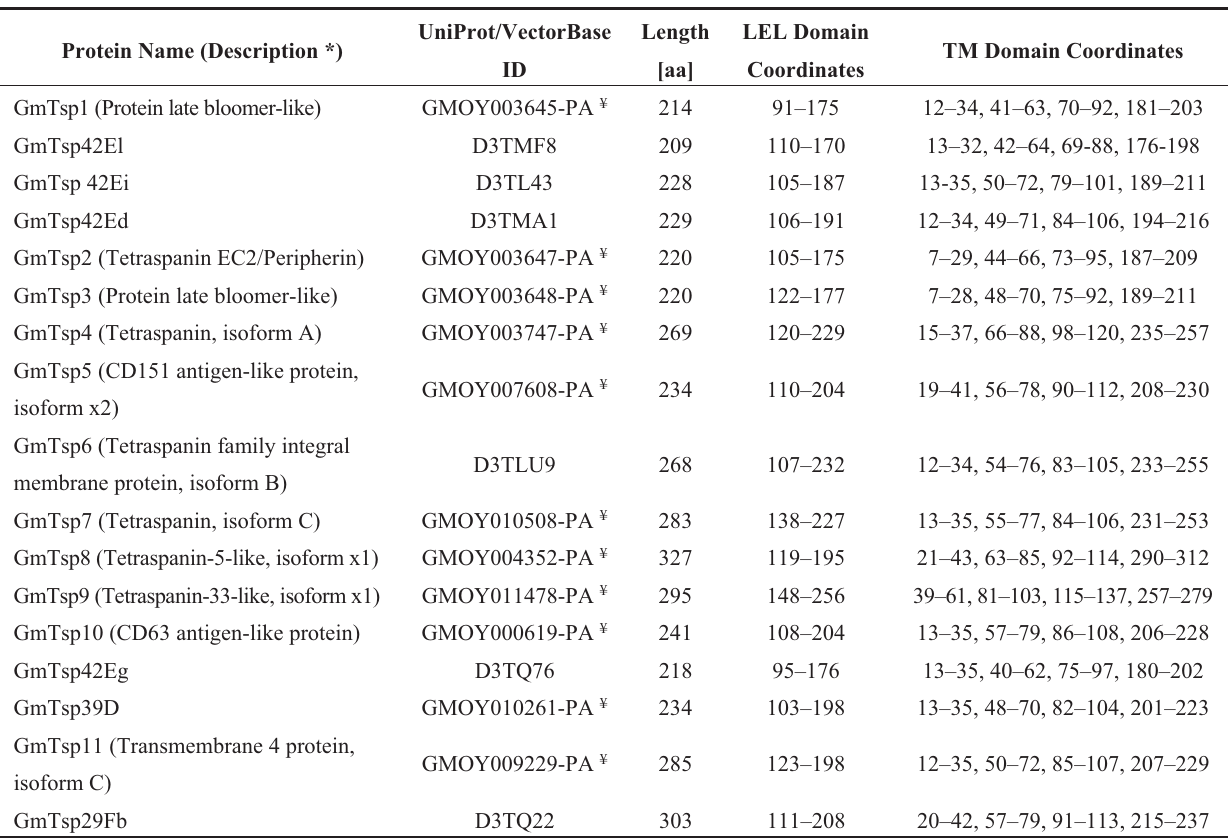
Table 1. Domain characteristics of seventeen GmTsp proteins in the genome of G. morsitans . The coordinates of the large extracellular loop (LEL) and the four transmembrane domains (TM) are shown in columns 4 and